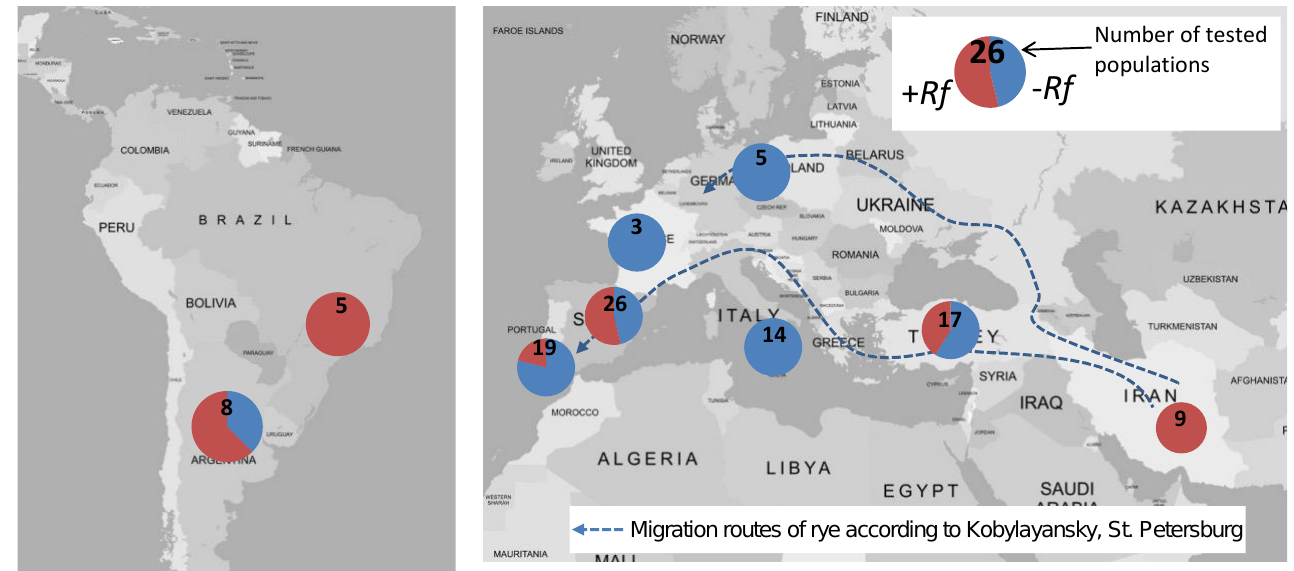
Figure 3. Frequency of Rfp1 from IRAN IX among 106 rye populations as tested by a gene-specific molecular marker.